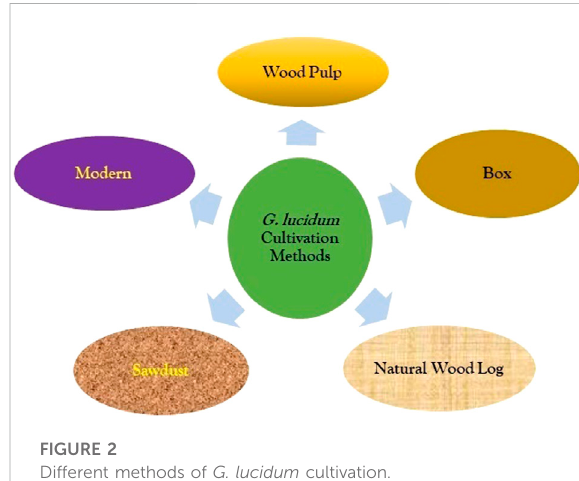
FIGURE 2 Different methods of G. lucidum